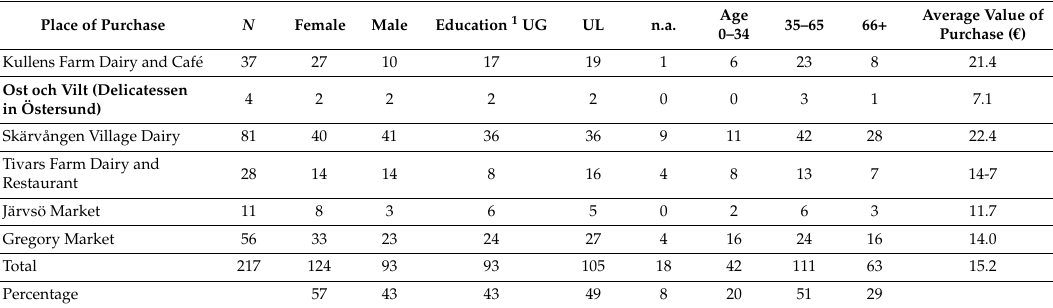
Table 1. The overview of the sample, n =